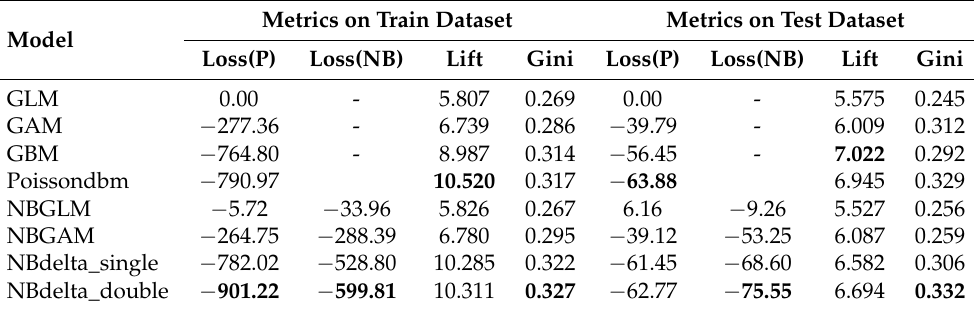
Table 3. Models’ comparisons based on common diagnostic